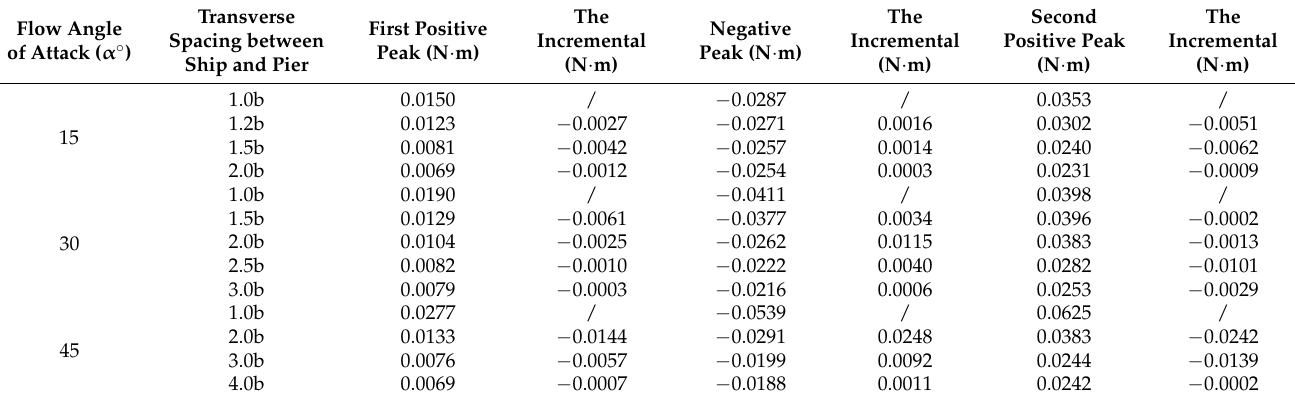
Table 5. Statistical table of bow roll moment peak values under different bridge spacings. Transverse Flow Angle Spacing of Attack ( α ◦ )